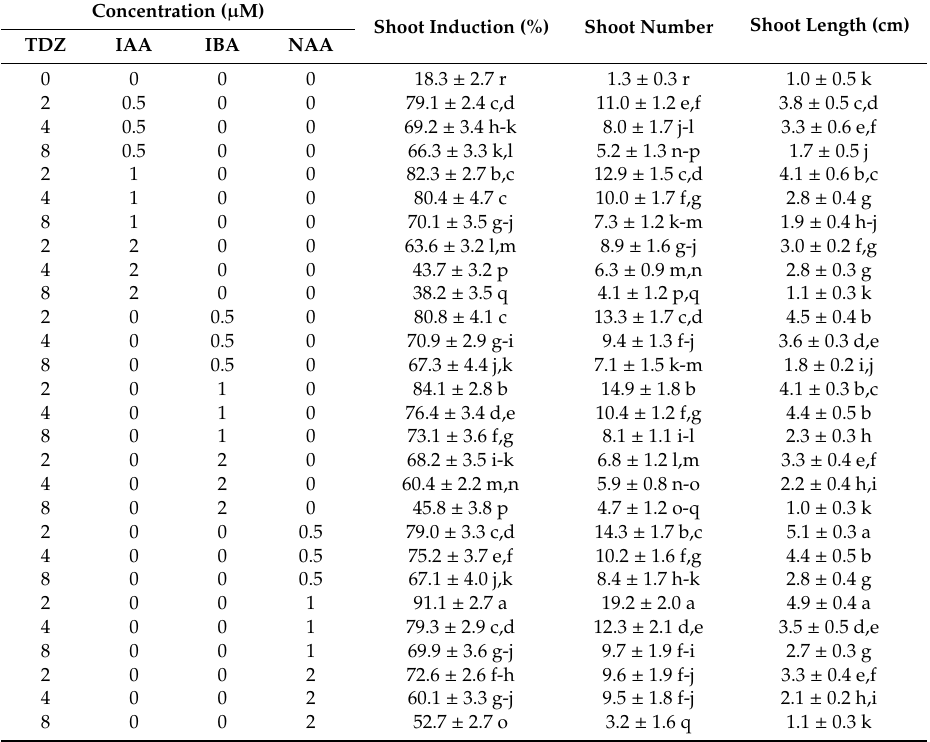
Table3. E ff ectofTDZplusauxinsonmultipleshootinductionfromnodalexplantsof Catharanthusroseus